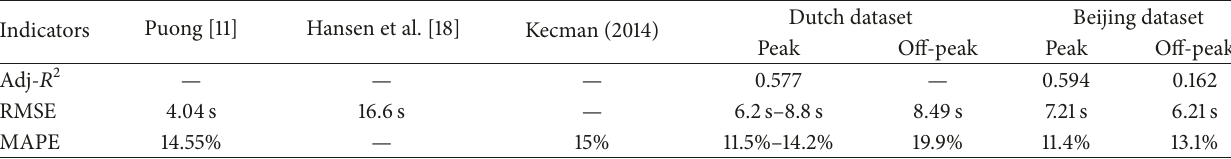
Table 8: Comparison of the regression results for different datasets.